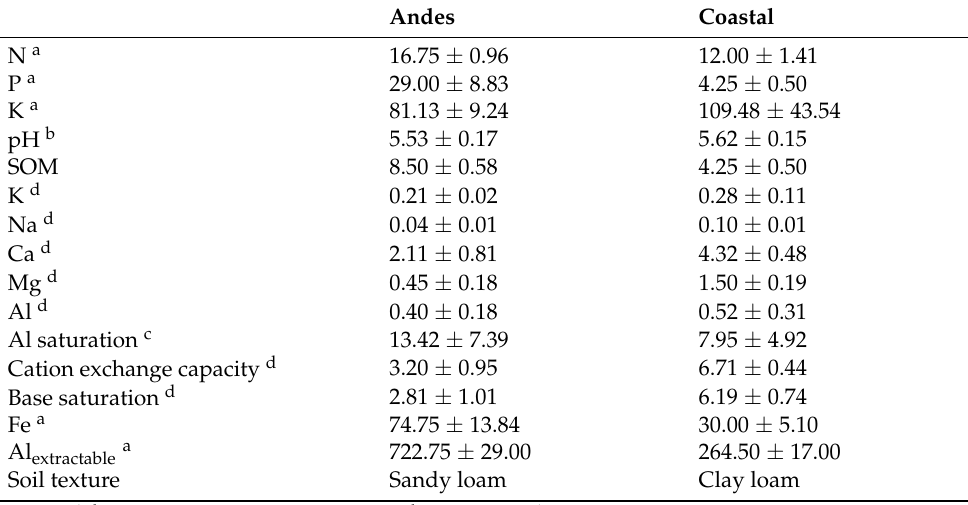
Table 2. Chemical characterization of soil associated with orchid hotspots in the Andes and Coastal site in south-central Chile. Results are means ± standard